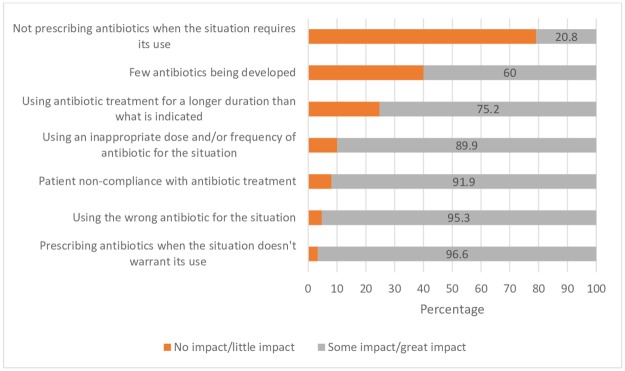
Perceptions of impact different factors have on antimicrobial resistance.NB: Responses were classed as a perception of ‘no impact/little impact’ if students rated between 0 (No Impact) and 4 on the 11 point Likert Scale. Responses were classed as a perception of ‘Some impact/great impact’ if students rated from 5 (Some Impact) to 10 (A Great Impact) on the Likert scale.